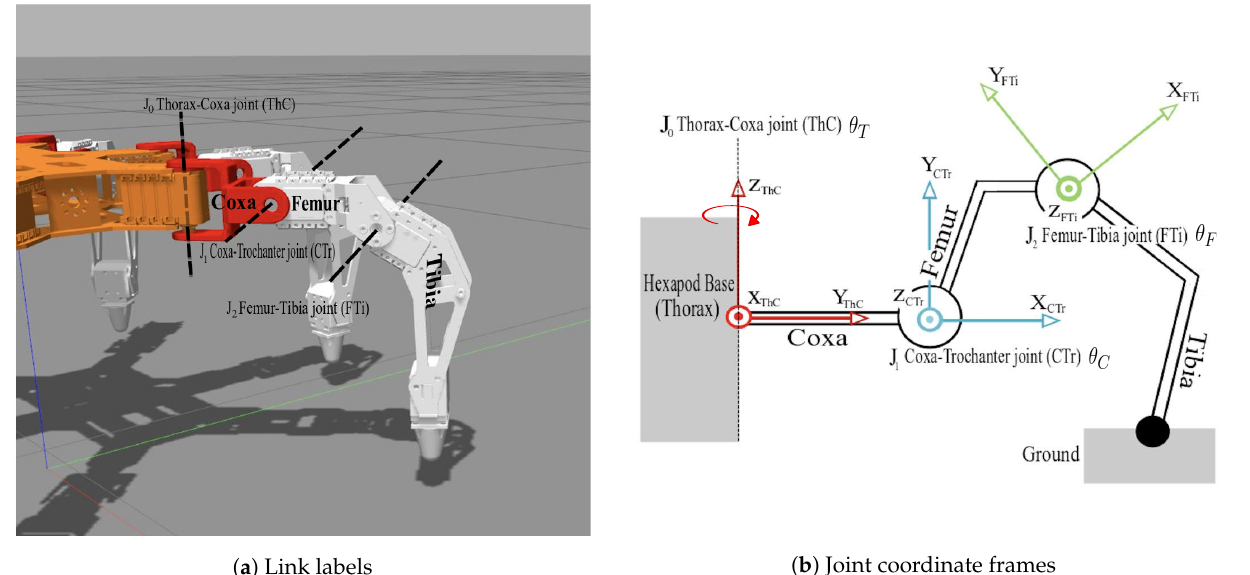
Figure 2. Hexapod leg links and coordinate frames ( a ) links and joint axes labeled on simulation ( b ) joint coordinate frames for each